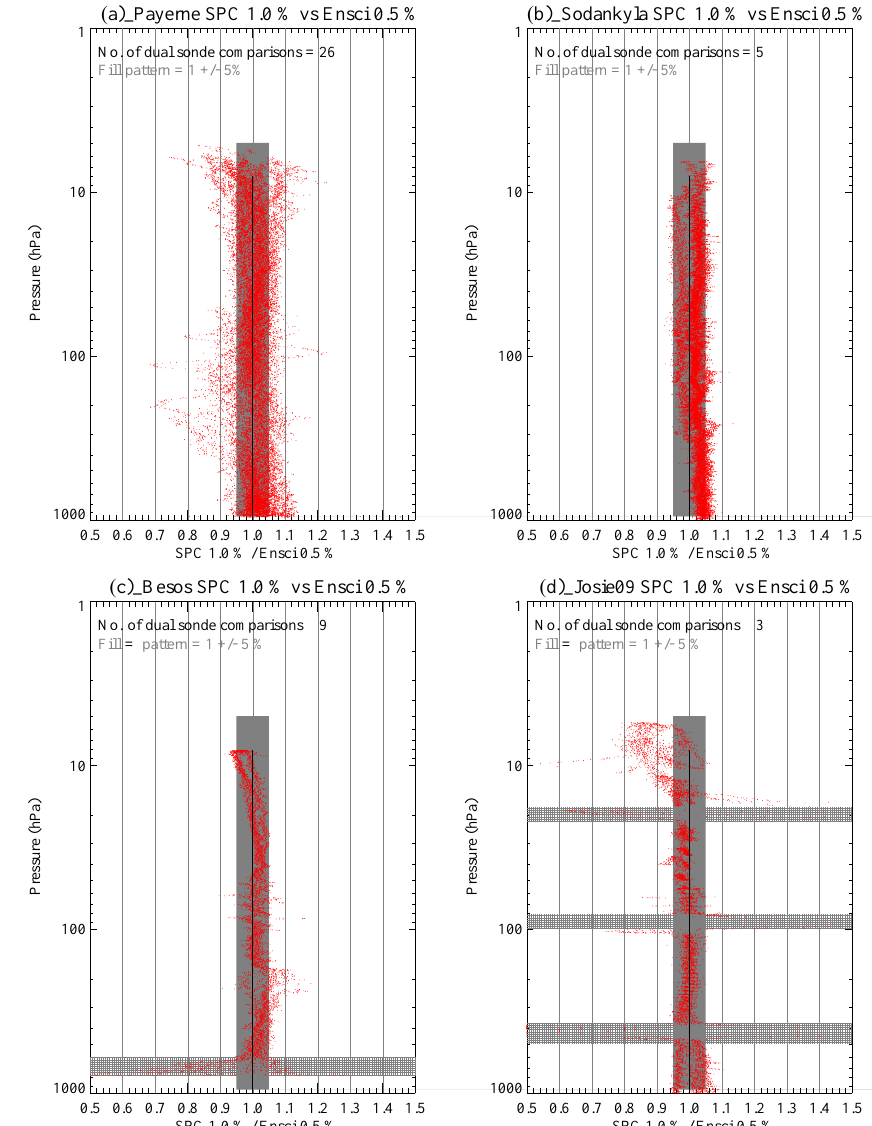
Figure 8. Ratios of SP-1.0% to EN-0.5% ozonesondes. The measurements are from (a) Payerne, (b) Sodankylä, (c) BESOS, and (d) JOSIE 2009. The filled regions represent 5% around 1.0. The hashed areas are as before to indicate regions of low ozone concentration during tests in JOSIE 2009 or difficulty with the data system in